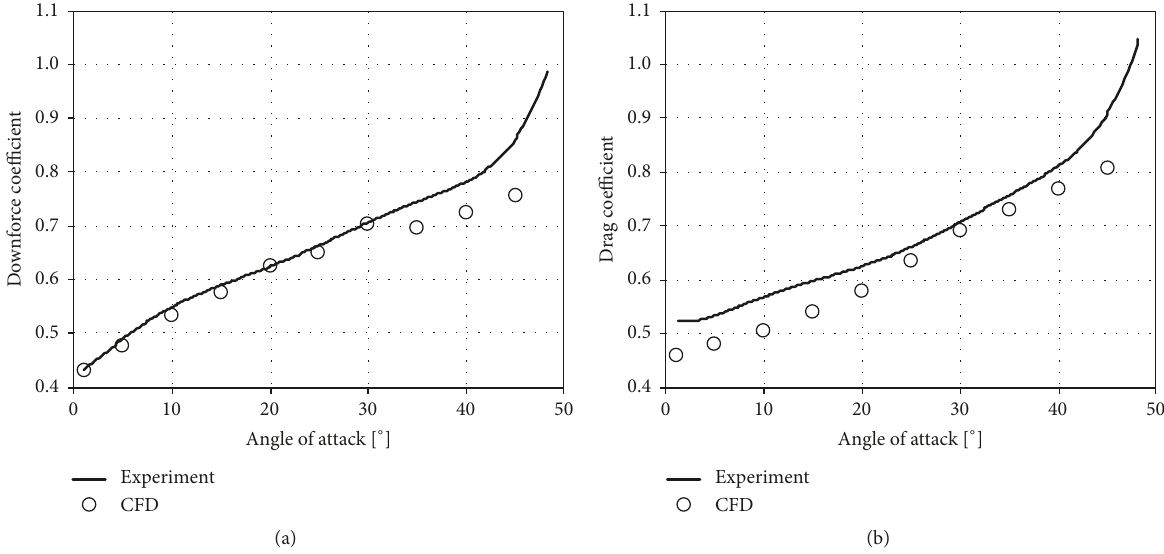
Figure 8: Characteristics of (a) the downforce coefficient and (b) the drag coefficient obtained during the wind tunnel measurements of a car with a mounted rear wing and a spoiler, compared with the CFD results acquired for a wide range of angles of